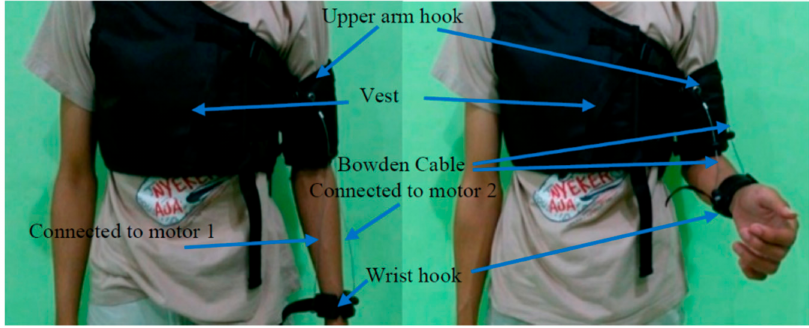
Figure 4. Portable soft exoskeleton for elbow assistance [7] (Open